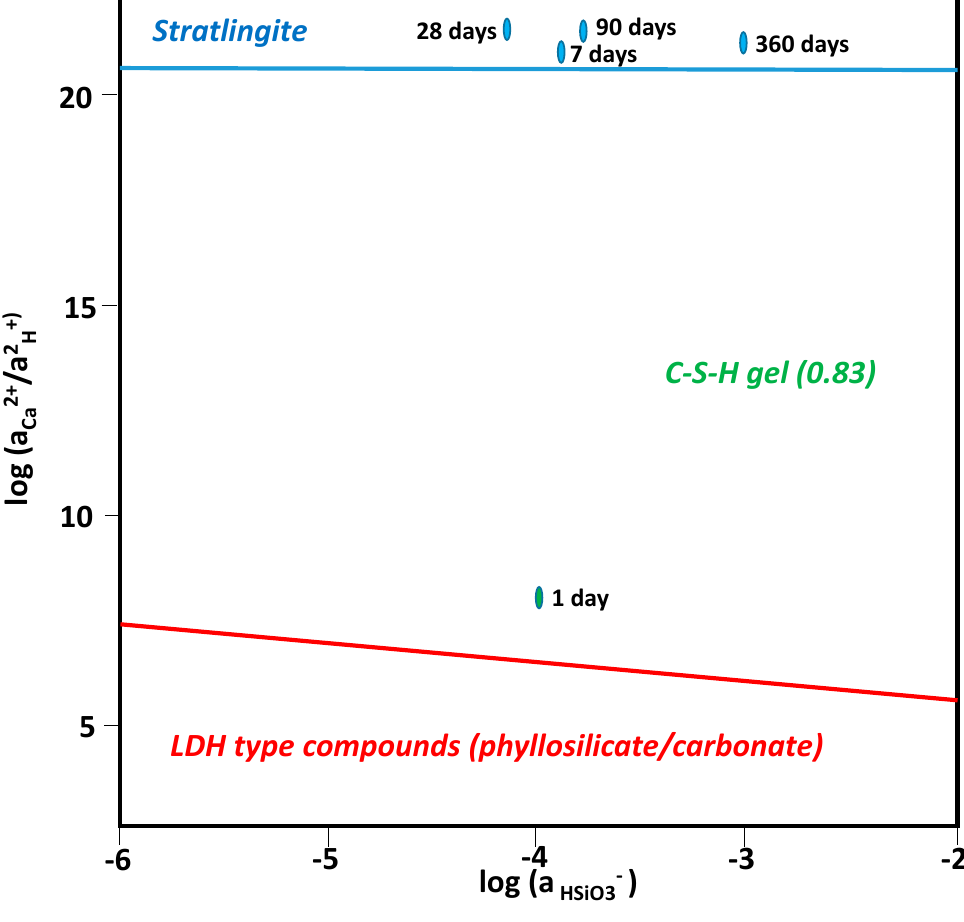
Figure 13. Plot of stability fields for LDH compounds + stratlingite + C-S-H gel system from the activated thermally kaolin systems.